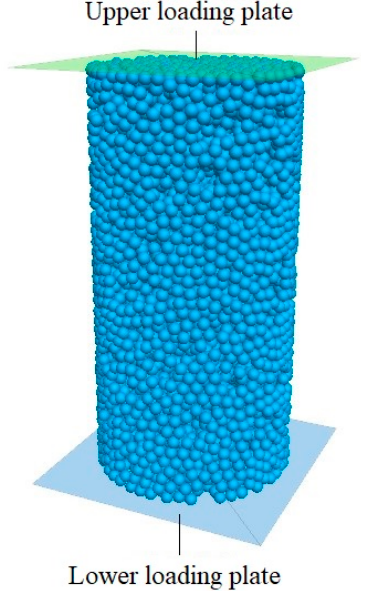
Figure 16. The calculation model for uniaxial compression of cylinder specimens.